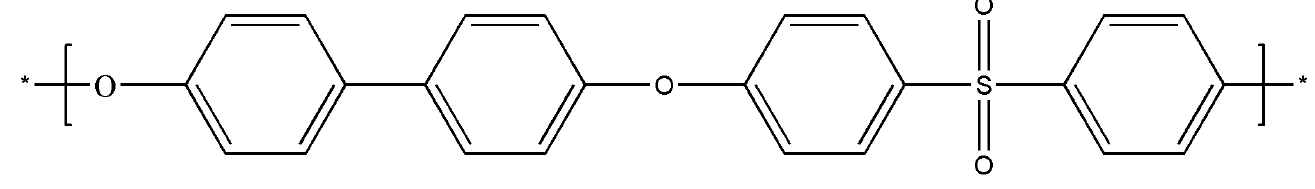
Figure 3. Polyarylethersulfone